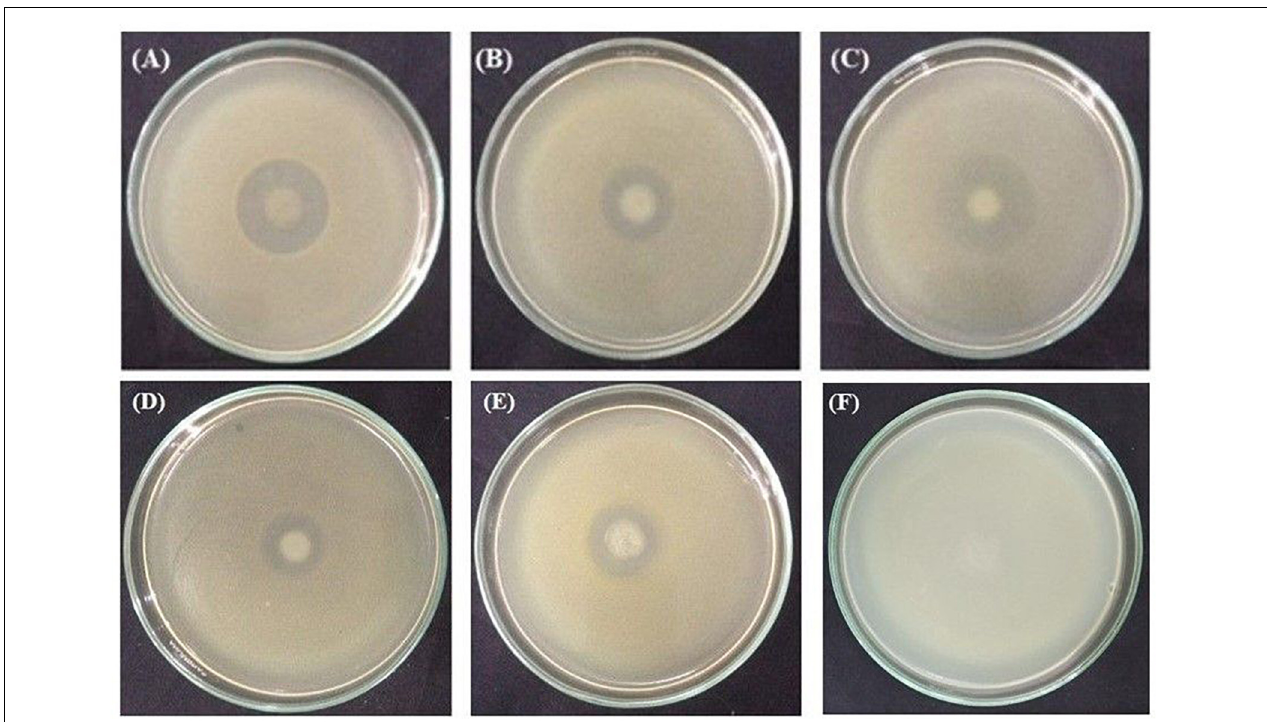
FIGURE 8 | Antagonism tests. Inhibition of X. campestris pv. campestris ATCC 33913 by P. cedrina ESR12 (A) , P. chlororaphis ESR15 (B) and B. cereus ESD3 (C) . Inhibition of R. solanacearum ATCC R (cid:13) 11696TM by P. chlororaphis ESR15 (D) , B. cereus ESD21 (E) , and negative control (F) . Photographs represent one of three experiments, which gave similar